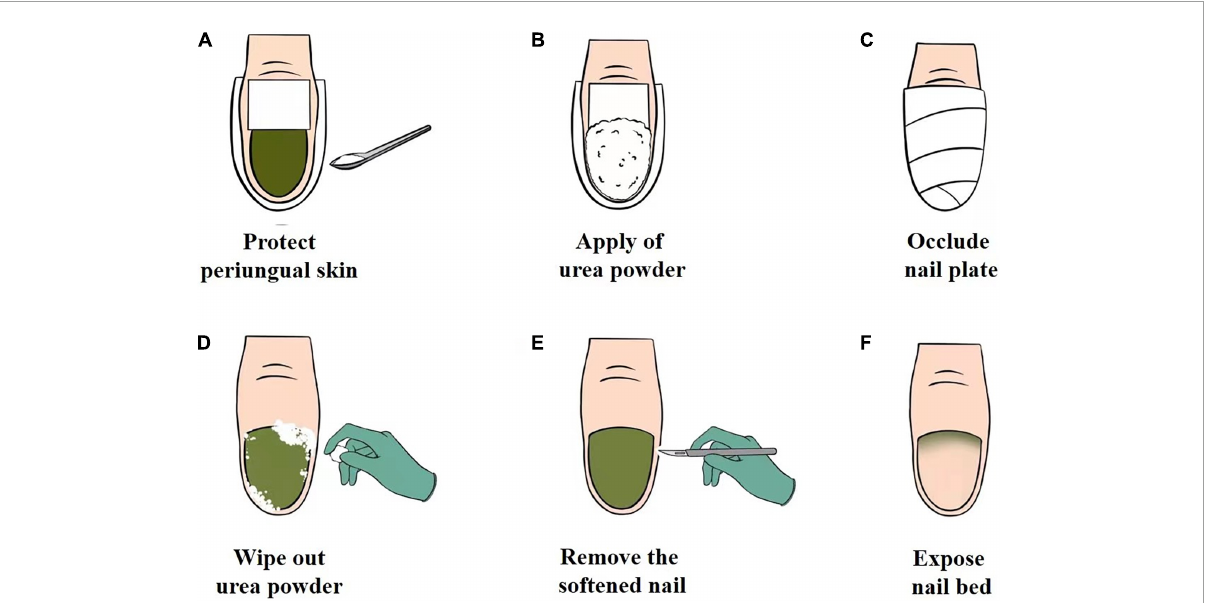
FIGURE4 (A–F) The operational chemical nail avulsion procedure using urea powder. (A) Protection of the periungual skin of the affected nail plate with waterproof plaster. (B) Application of urea powder to the affected nail plate. (C) Occlusion of the affected nail plate with waterproof plaster. (D) Removal of urea powder with an alcohol cotton ball. (E) Removal of the softened nail. (F) Exposure of the nail